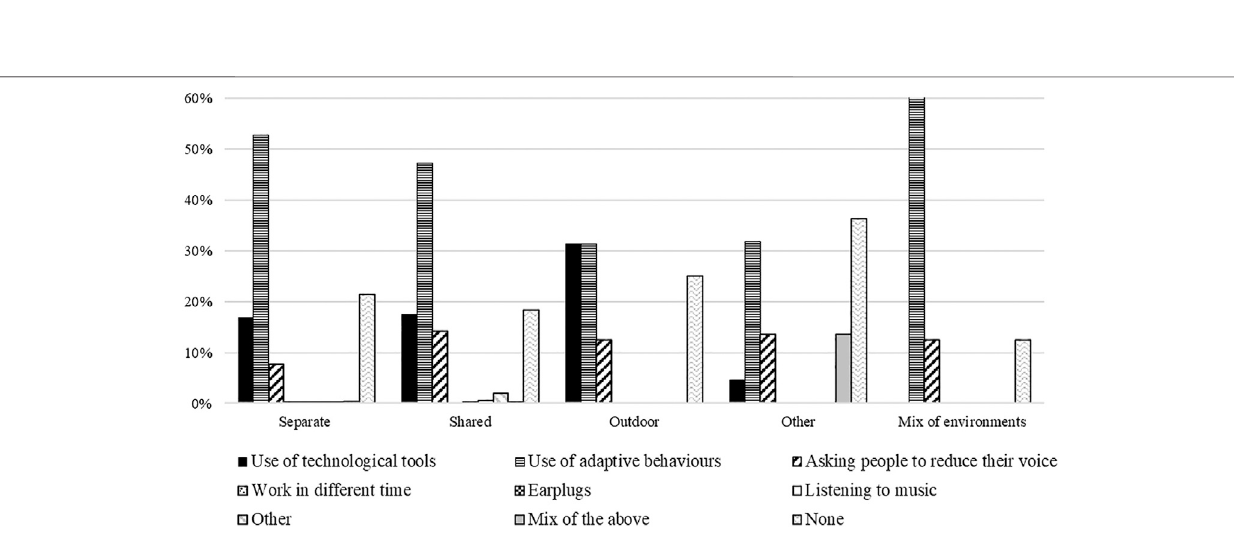
Frontiers in Built Environment |